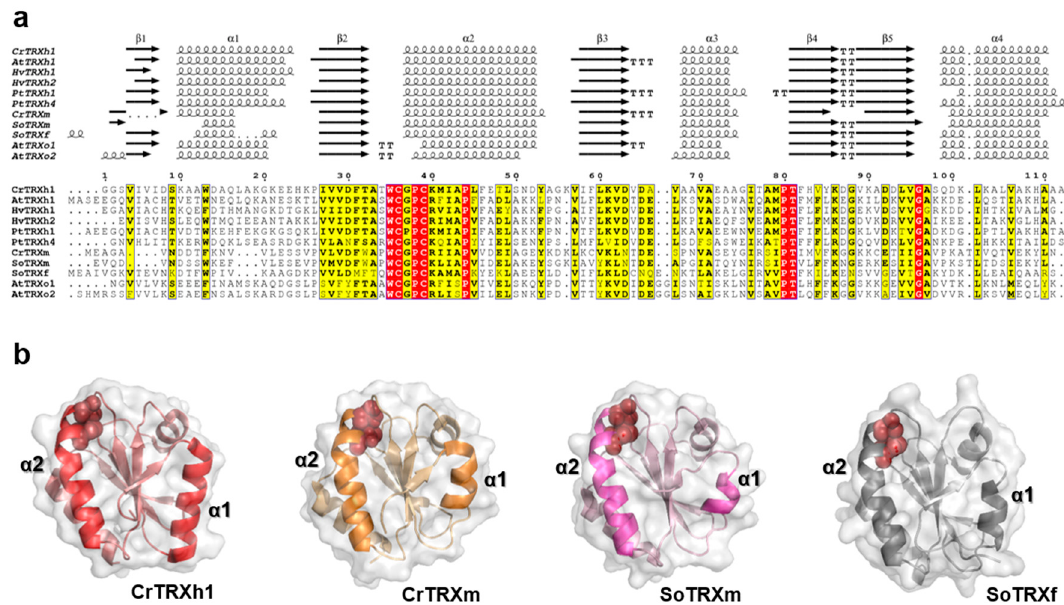
Figure 1. Sequence analysis and structural representation of plant TRXs. ( a ) Multiple sequence alignment of structurally solved plant TRX isoforms was performed with ESPript (http://espript.ibcp.fr, [42]) using Chlamydomonas reinhardtii (Cr) TRX h1 (Protein Data Bank (PDB) ID: 1EP7, [19]) and TRX m (PDB ID: 1DBY, [25]), Arabidopsis thaliana (At) TRX h1 (PDB ID: 1XFL, [26]), TRX o1 (PDB ID: 6G61, [27]), and TRX o2 (PDB ID: 6G62, [27], Hordeum vulgare (Hv) TRX h1 (PDB ID: 2VM1, [28]) and TRX h2 (PDB ID: 2IWT, [28]); Populus trichocarpa (Pt) TRX h1 (PDB ID: 1TI3, [29]) and TRX h4 (PDB ID: 3D21, [30]), and Spinacia oleracea (So) TRX f (PDB ID: 1F9M, [31]) and TRX m (PDB ID: 1FB0, [31]). Conserved residues are highlighted in white on red boxes, whereas residues with similar physicochemical properties are written in black on yellow boxes. The sequence identities were calculated with Clustal Omega [43]. ( b ) Ribbon representation of the three-dimensional structures of CrTRXh1, CrTRXm, SoTRXm, and SoTRXf. The structural elements α -helix 1 and α -helix 2 are labeled; and active site cysteines are shown as red balls.